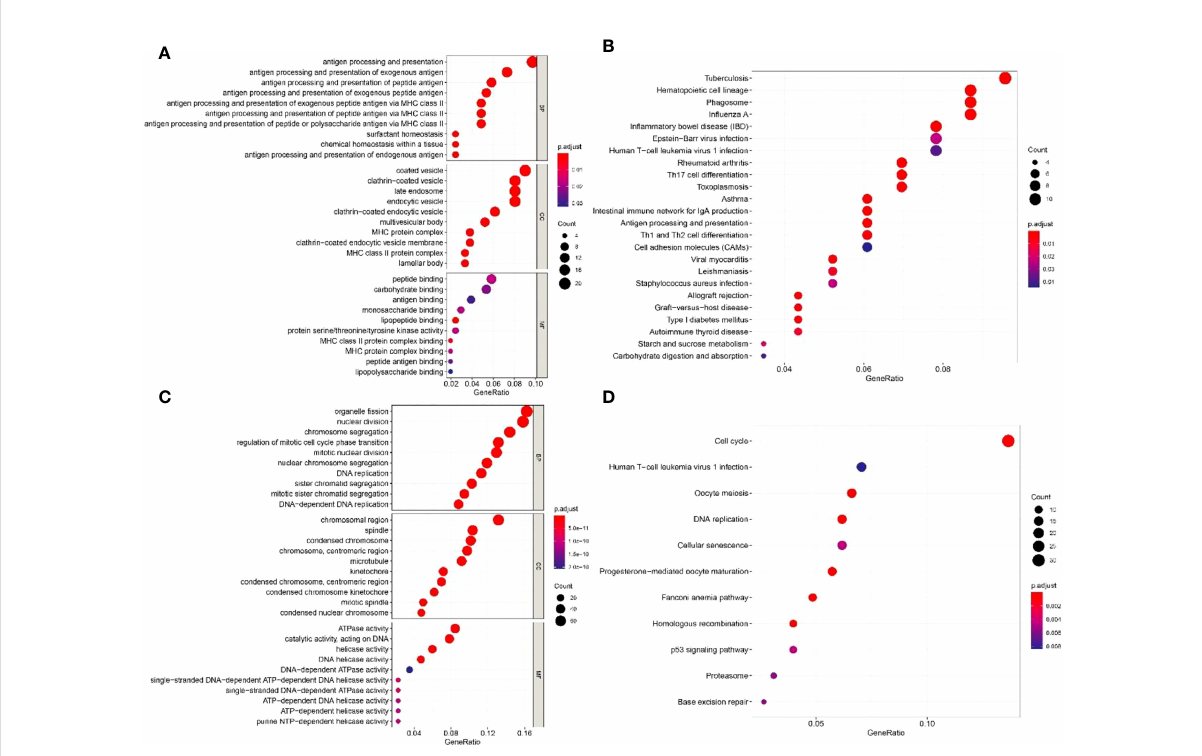
FIGURE 8 The GO and KEGG enrichment analyses of IGF2BP1-related genes. (A) GO enrichment analysis of 50 positively related genes of IGF2BP1. (B) KEGG enrichment analysis of 50 positively related genes of IGF2BP1. (C) GO enrichment analysis of 50 negatively related genes of IGF2BP1. (D) KEGG enrichment analysis of 50 negatively related genes of